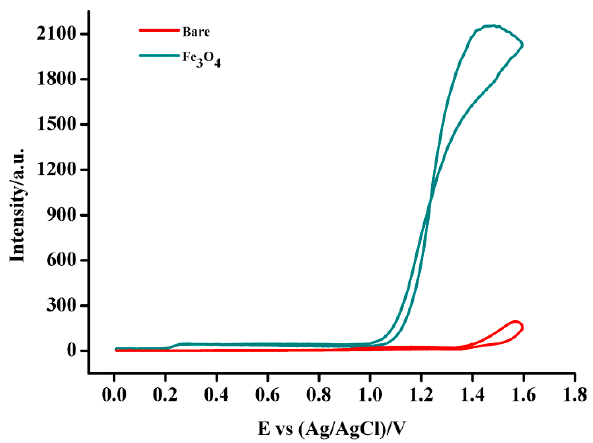
Figure 4. ECL intensity of luminol in bare GCE and Fe 3 O 4 -NCs/GCE under 0.01 M NaOH (pH 11.0) and 6.0 × 10 − 6 M luminol.